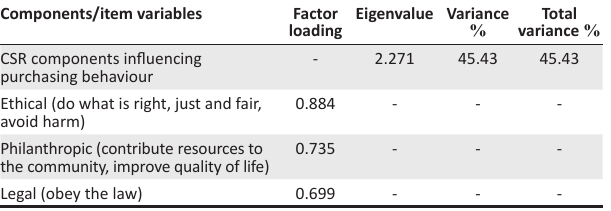
TABLE 2: Factor analysis on individual evaluation of corporate social responsibility